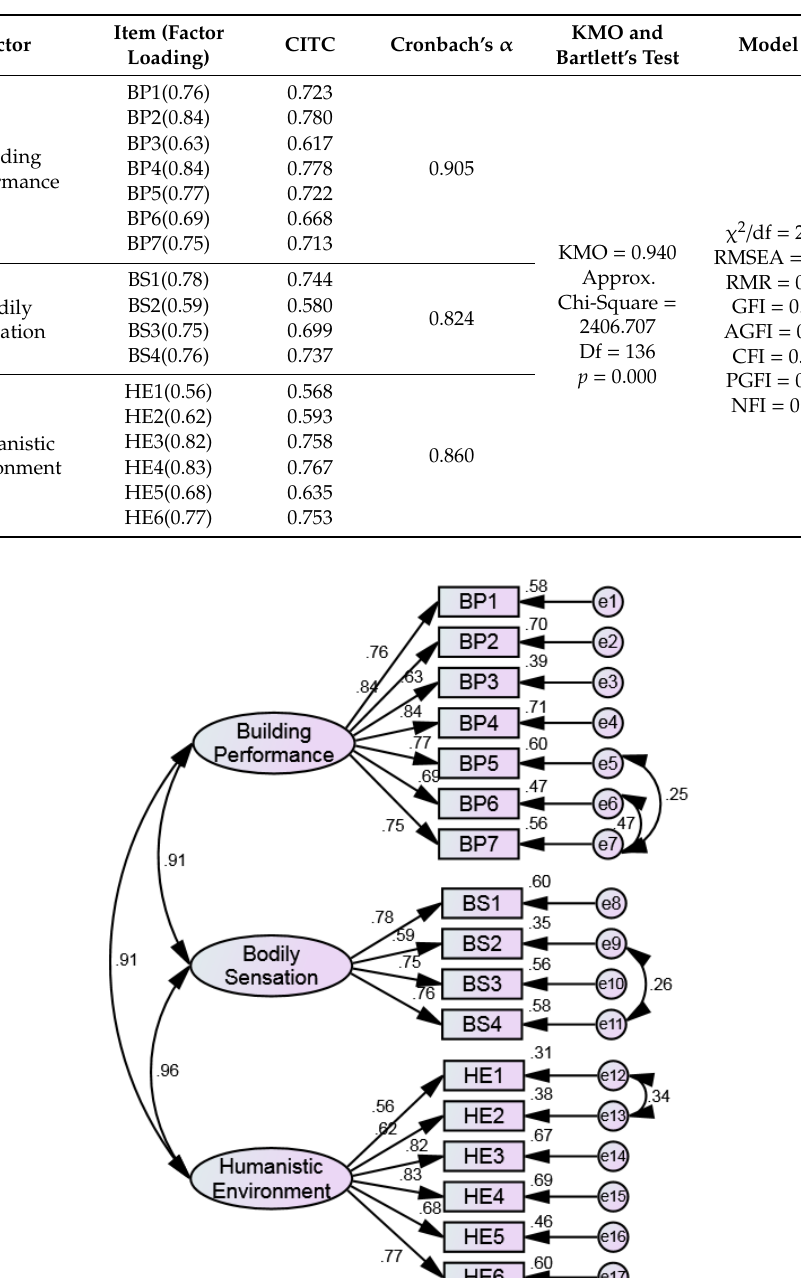
Table 2. Reliability and validity analysis.